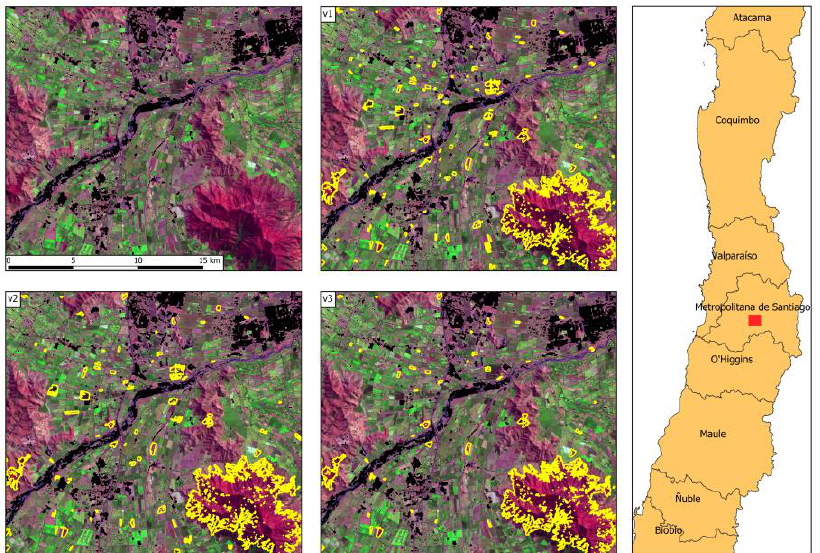
Figure 1. Comparison of different versions of the BA product (yellow line) in a sample area located in the Santiago Metropolitan Region. The background image is the postfire image composite resulting from the combination of the available images from January 1 st to March 31 st